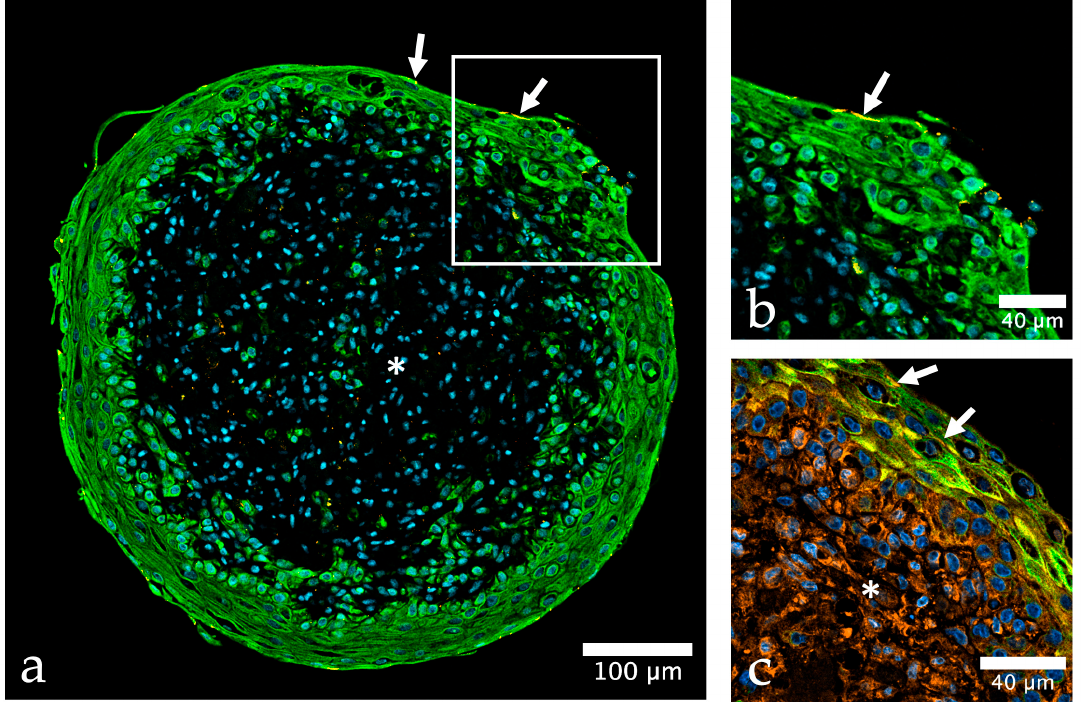
Figure 2. Urinary bladder organoid composed of three different human urinary bladder cell types. ( a ) The organoid shows a clear stratification into outer non-malignant urothelial cells (HBLAK, green) and a core of urinary bladder fibroblasts and smooth muscle cells (HBF, HBSMC); urothelial cells are positive for cytokeratin (green, CKPAN), whereas HBF and HBSMC are negative (asterisk), the tight junction protein zonula occludens-1 (ZO-1) is depicted in orange, nuclei are shown in blue color (stained with TO-PRO-3); ( b ) detail of ( a ) demonstrate that the expression of ZO-1 (orange) is mostly restricted to the top cell layer of HBLAK cells (arrows in ( a , b )), while vinculin (VCL, orange) expression ( c ) is very strong in both, HBLAK and stromal cells (asterisk); antibodies used (Table S1).